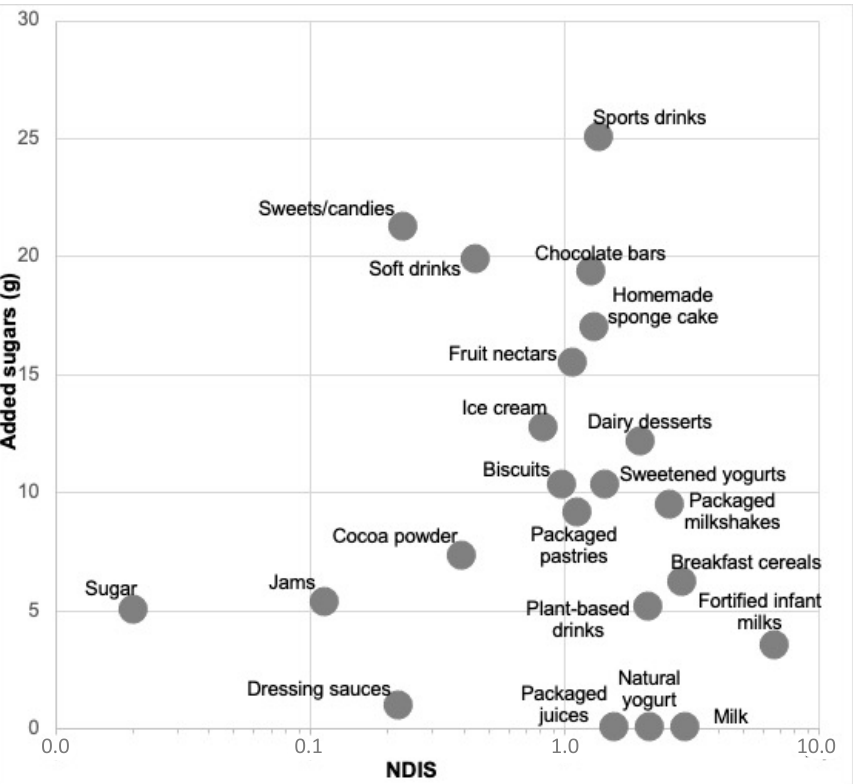
Figure 2. NDIS (nutritional density index per serving) vs. added sugars per serving of food.